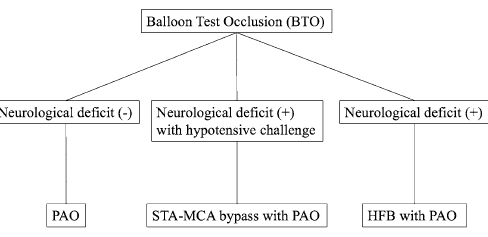
Figure 4. Operative strategy for large or giant aneurysms in the cavernous portion of the internal carotid